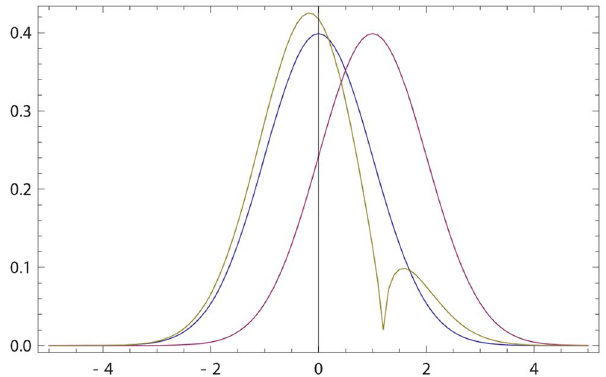
Figure 6. Opinion change in the boomerang regime. Blue (resp. purple) curve: the initial opinion of agent P (resp. Q ) described by probability density p ( x ) (resp. q ( x )). Olive curve: the final opinion ~ pp ( x ) of P given by (16) with E ~ 2 . Here p ( x ) and q ( x ) are given by (17) with m P ~ 0 and v P ~ m Q ~ v Q ~ 1 . The anchor (maximally probable opinion) of P not only moves away from the anchor of Q ; but it is also enhanced: the (biggest) peak of ~ pp ( x ) is larger than that of p ( x ). The second (smaller) peak of ~ pp ( x ) arises because the initial probability of P located to the right from the anchor m Q of Q , moves away from m Q ; ~ pp ( x ) gets a local minimum close to m Q